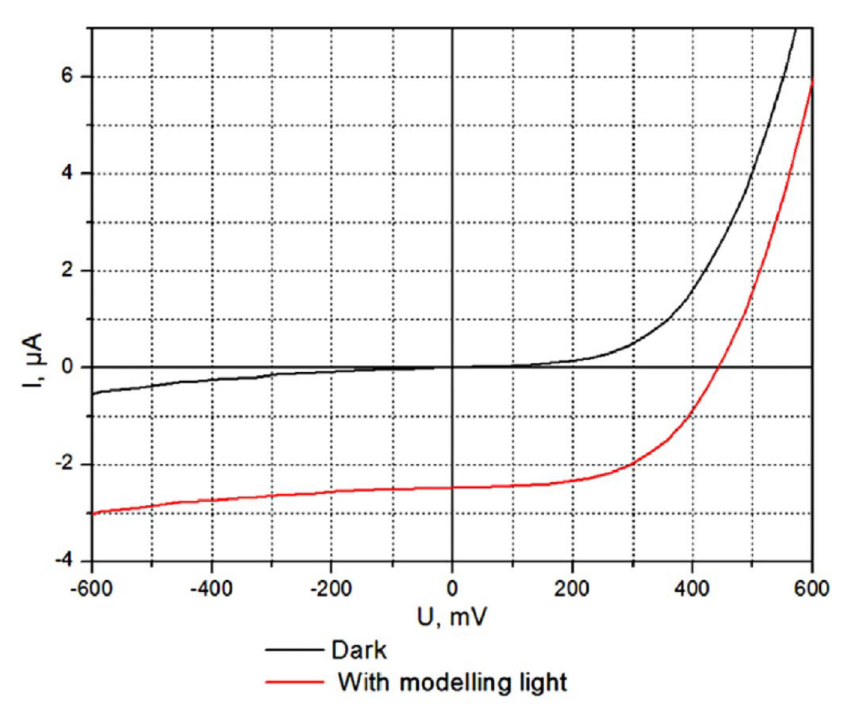
Figure 8. The I ‐ V characteristics of an experimental 3D BVC structure. Reproduced with permis ‐ Figure 8. TheI-Vcharacteristicsofanexperimental3DBVCstructure. sion from [125].